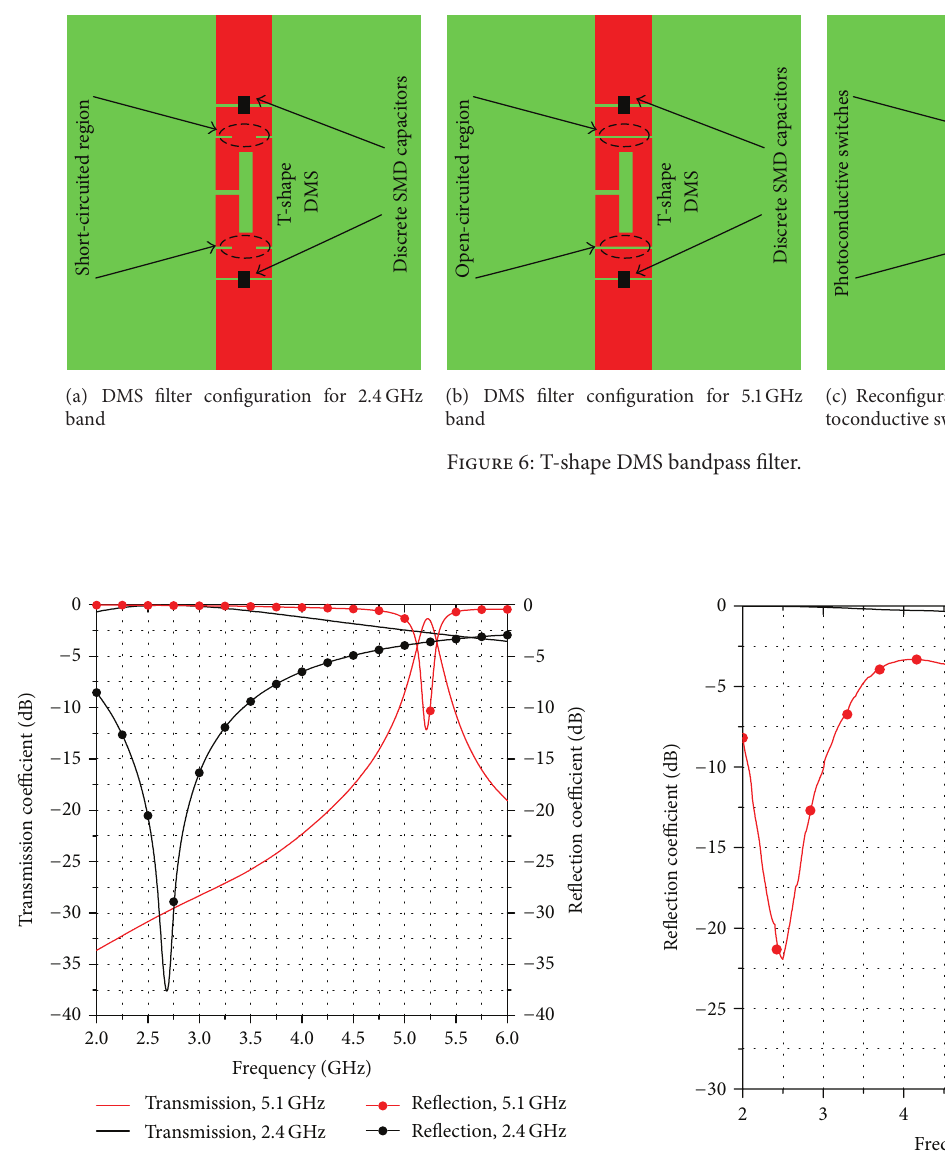
Figure 7: T-shape DMS reconfigurable bandpass filter frequency response.